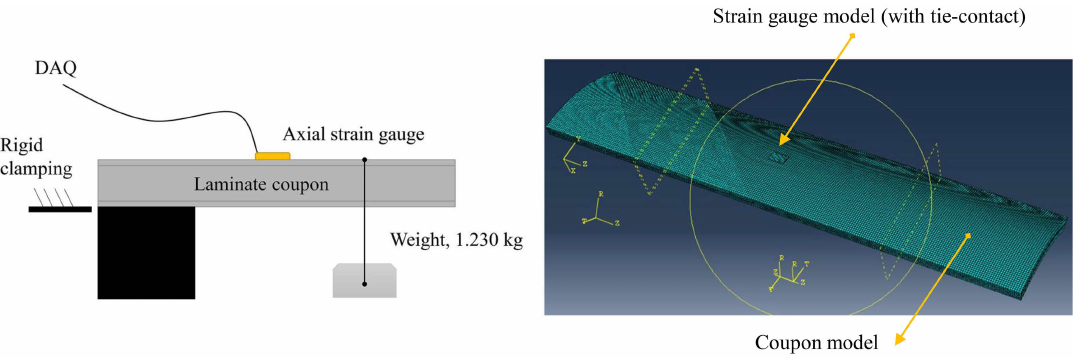
Figure 5. Experimental arrangements and the finite element model of the test coupon to determine thermal expansion